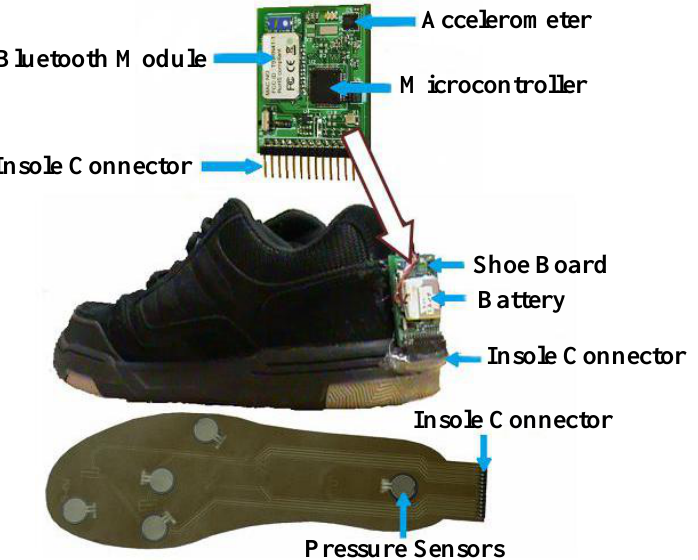
Figure 28. Edgar et al. [10] shoe